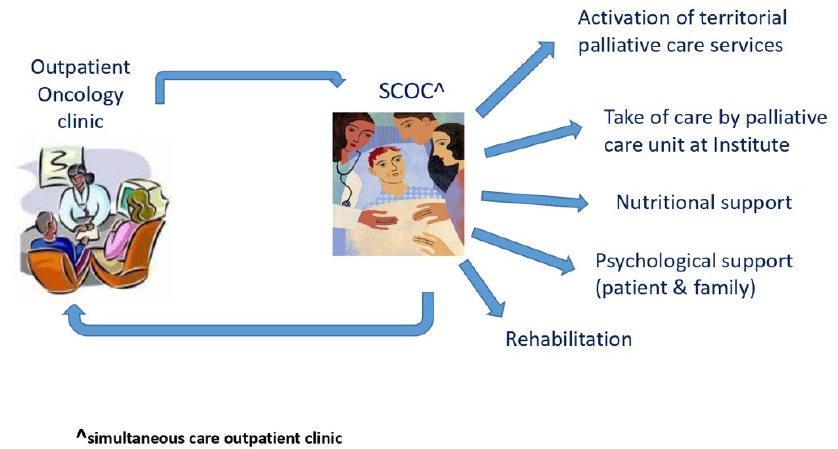
Figure 1. Patient journey.